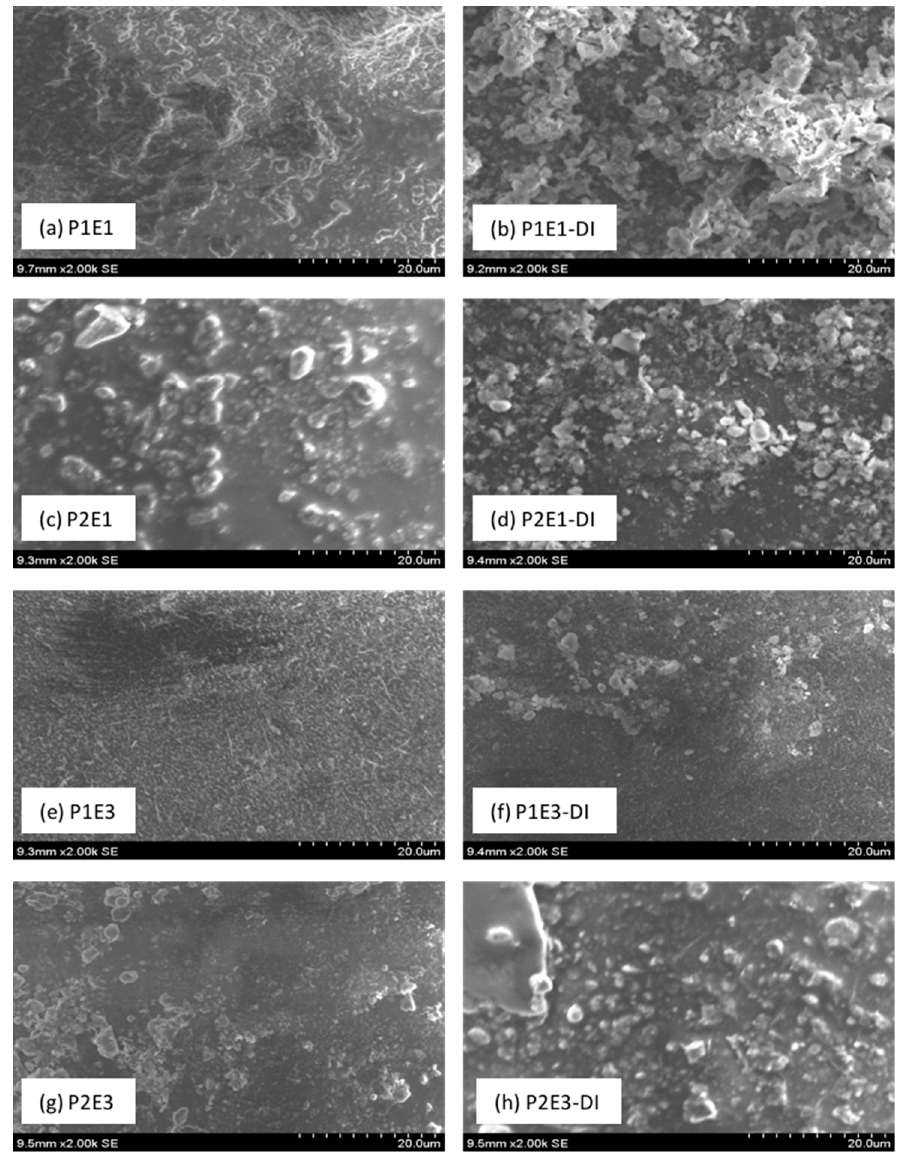
Figure 6. Scanning electron micrographs (SEM) of RO membranes. ( a ), Phase 1 Element 1 (P1E1); ( b ), Phase 1 Element 1, DI water rinsed (P1E1-DI); ( c ), Phase 2 Element 1 (P2E1); ( d ), Phase 2 Element 1, DI water rinsed (P2E1-DI); ( e ), Phase 1 Element 1 (P1E3); ( f ), Phase 1 Element 3, DI water rinsed (P1E3-DI); ( g ), Phase 2 Element 3 (P2E3); ( h ), Phase 2 Element 3, DI water rinsed (P2E3-DI).